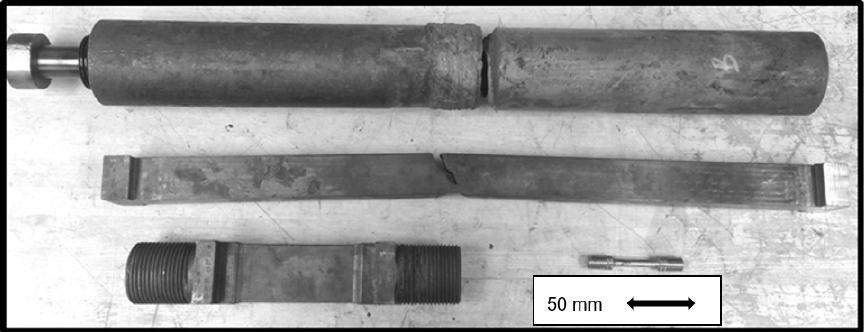
Figure 17. Examples of the feature test cross weld specimens used by EPRI to evaluate the factors affecting the creep behaviour of pressure boundary joints in tempered martensitic